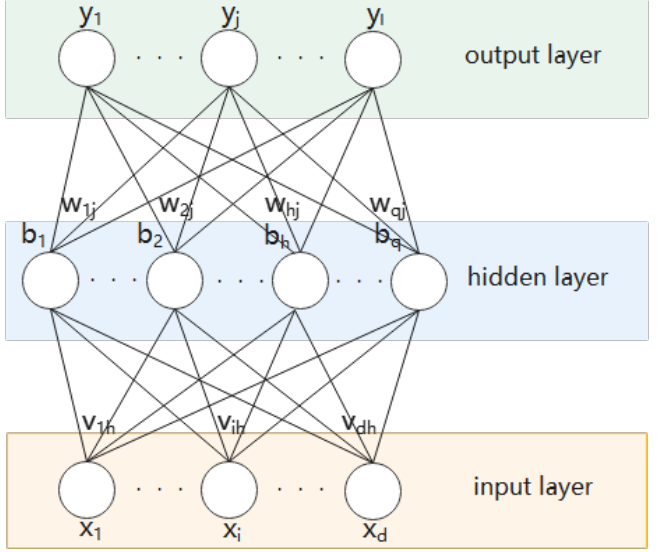
Figure 9. BP neural network topology. v ih